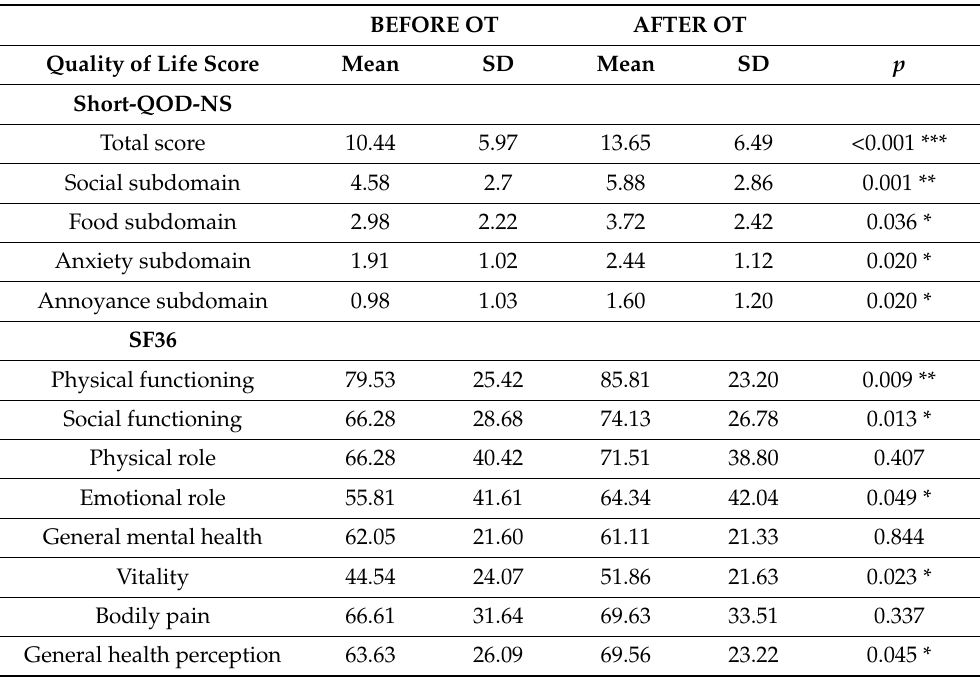
Table 2. Olfactory specific (Short-QOD-NS) and general (SF-36) quality of life comparative results before and after olfactory training (OT). SD represents the standard deviation. p represents the p -value at the Wilcoxon signed-rank test. * p < 0.05; ** p < 0.01; and *** p <